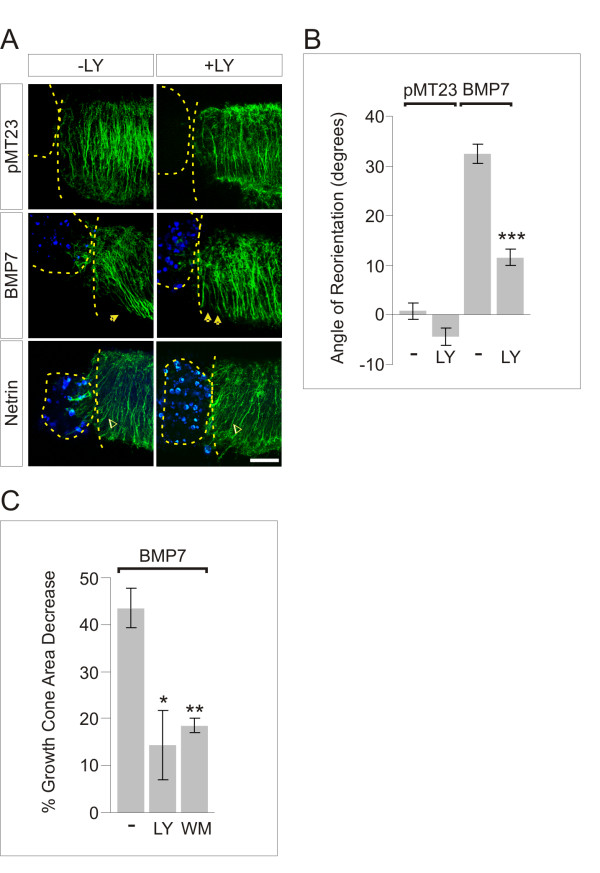
BMP7-evoked growth cone collapse and axon orientation is dependent on PI3K activity. (A) [d] explants cultured as in Figure 5C with control- or BMP7- (blue; α-flag) or Netrin-1- (blue; α-Netrin) expressing COS-1 cells, with or without 2.5 μM LY (+LY). Green shows TAG-1-labeled axons. Dashed lines mark COS-1 cell aggregate and [d] explant appended borders. The closed single arrowhead indicates dI axons repelled by BMP7. The double closed arrowheads indicate angle of axons with LY. Open arrowheads indicate dI axons attracted by Netrin-1. Scale = 50 μm. (B) Angle of reorientation in [d] explants co-cultured with or without BMP7 and with or without LY (mean ± SEM for each condition): pMT23 = 0.8 ± 1.7° (n = 9); pMT23 + LY = -4.3 ± 1.8° (n = 3); BMP7 = 32.5 ± 1.9° (n = 18); BMP7 + LY = 11.6 ± 1.7° (n = 29). Student's t-tests: the straight D-V projection of axons in control [d] explants was unchanged by LY (pMT23 - LY versus pMT23 + LY, P = 0.1412). BMP7-evoked reorientation was significantly inhibited by LY (BMP7 - LY versus BMP7 + LY, ***P < 0.0001). Attraction of dI axons by Netrin-1 was unchanged by LY (Netrin - LY = 51.5 ± 3.5° (n = 3); Netrin + LY = 49.0 ± 1.5° (n = 4); Netrin - LY versus Netrin + LY, P = 0.4621). (C) BMP7-evoked dI growth cone collapse measured with or without LY or WM. Percentage decrease of growth cone area relative to control cultures (mean ± SEM): BMP7 = 44 ± 4% (n = 3); BMP7 + LY = 14 ± 7% (n = 2); BMP7 + WM = 19 ± 2% (n = 3). BMP7-stimulated reduction in growth cone area was significantly different from cultures treated with BMP7 + LY or BMP7 + WM (BMP7 - LY versus BMP7 + LY, *P < 0.05; BMP7 - WM versus BMP7 + WM, **P < 0.005; (Student's t-test)). Results are for 200 to 400 growth cones/condition/experiment.